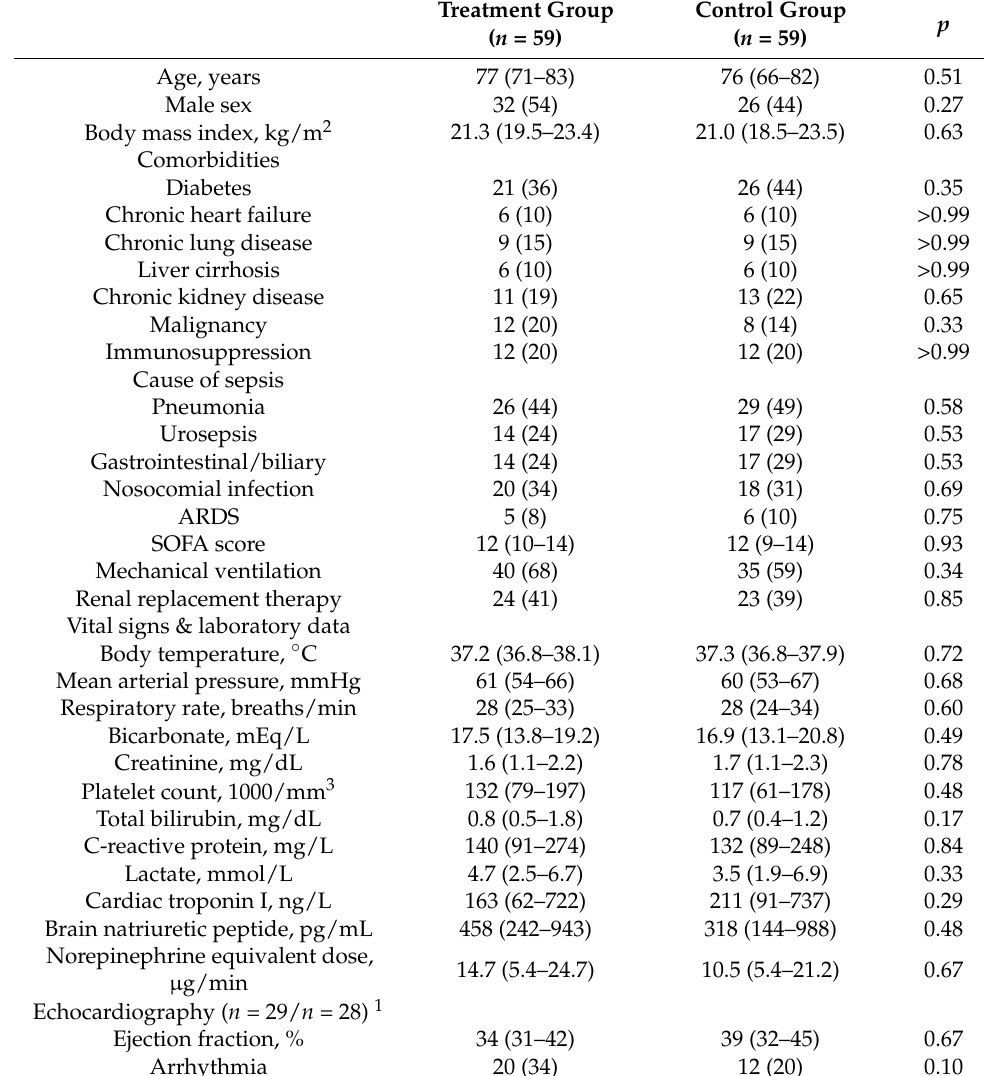
Table 1. Baseline characteristics of the groups after matching.